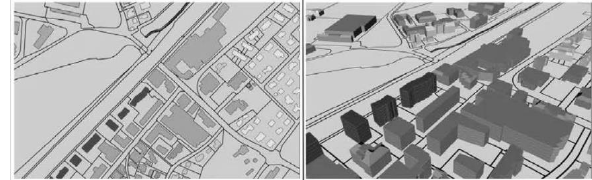
Figure 3. Viewing a specific type of zoning plan (atypical) in 2D (left) or in 3D (right) could make a difference in participant performance as well as attitudes. Note that both the dimensionality and the viewing perspective changes here, and therefore different information are